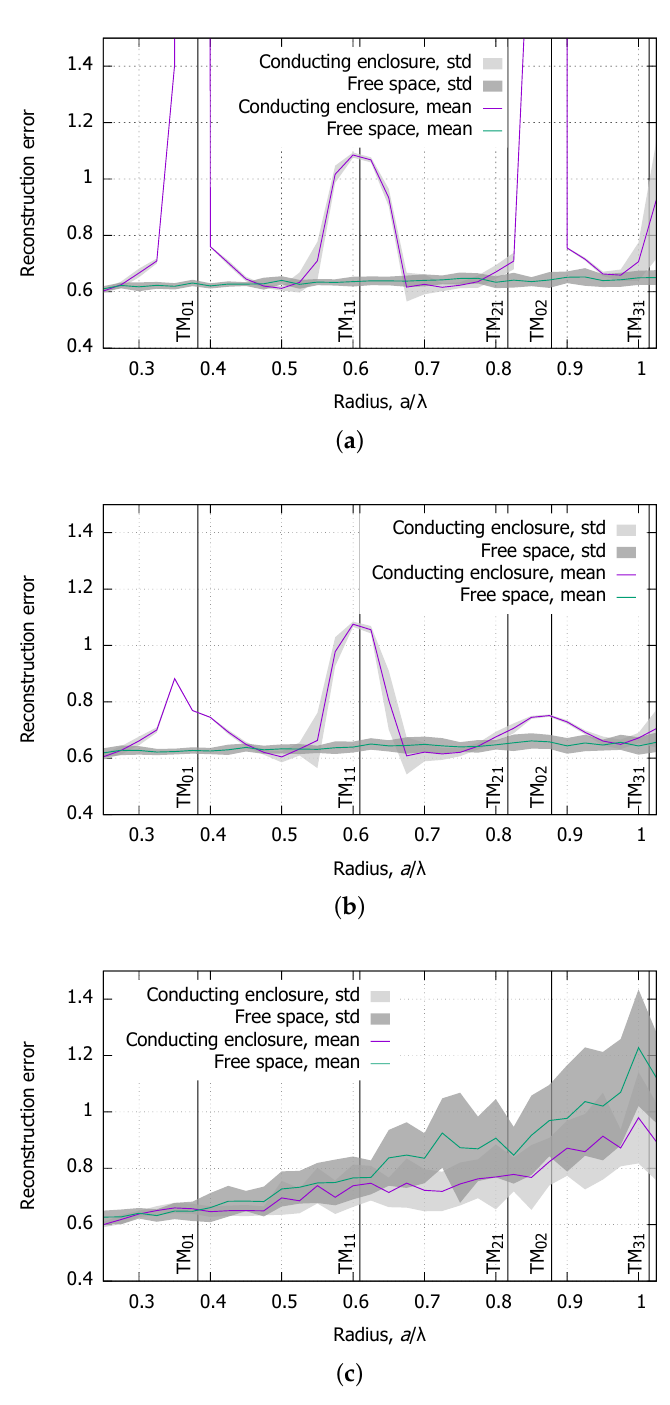
Figure 5. Small conducting enclosure. Reconstruction error versus the radius of the conducting enclosure, for three values of the background conductivity: ( a ) lossless, σ b = 0 S/m; ( b ) σ b = 1 mS/m; ( c ) σ b = 10